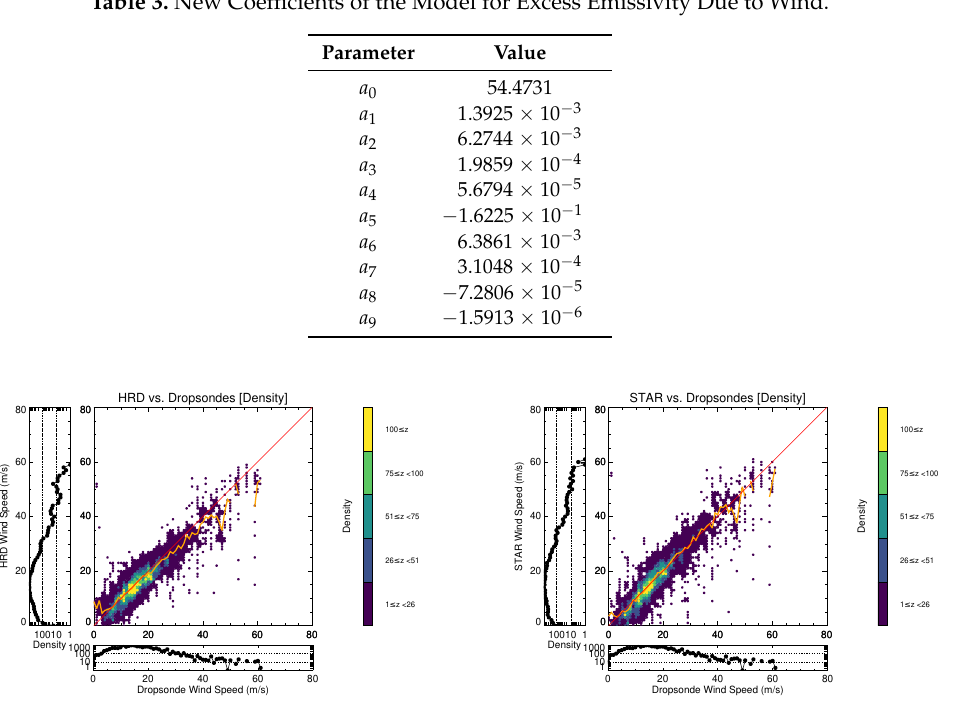
Figure 6. SFMR wind-speed error as a function of dropsonde surface wind speed (U 10N ) estimate for both HRD and STAR retrievals. Points are colored by the number of points in each two-dimensional bin. One-dimensional histograms are shown for each 1ms − 1 bin on the left for retrievals and bottom for dropsondes. A solid orange line indicates the mean of the vertical axis for each horizontal